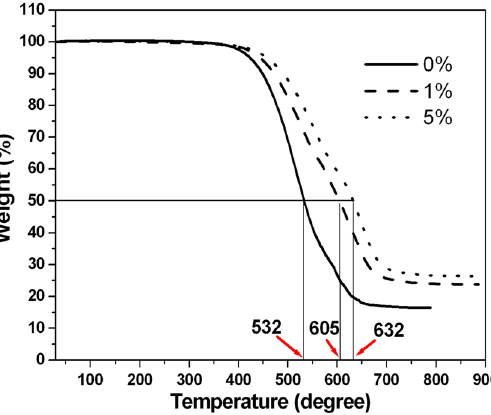
Figure 6. TGA curves of pure silence resin and S-TiO 2 /silicone nanocomposites with 1 wt% and 5 wt% S-TiO 2